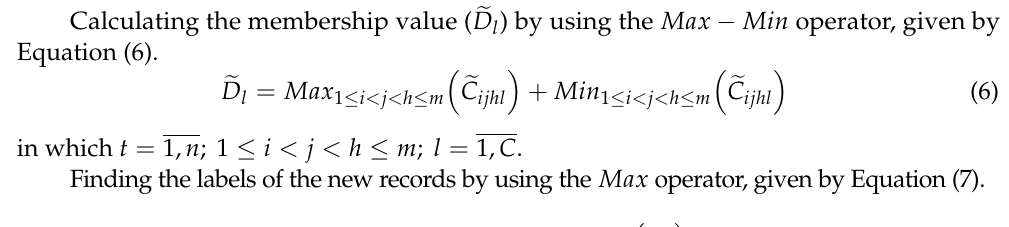
Figure 2. The proposed model of preeclampsia sign diagnosis.